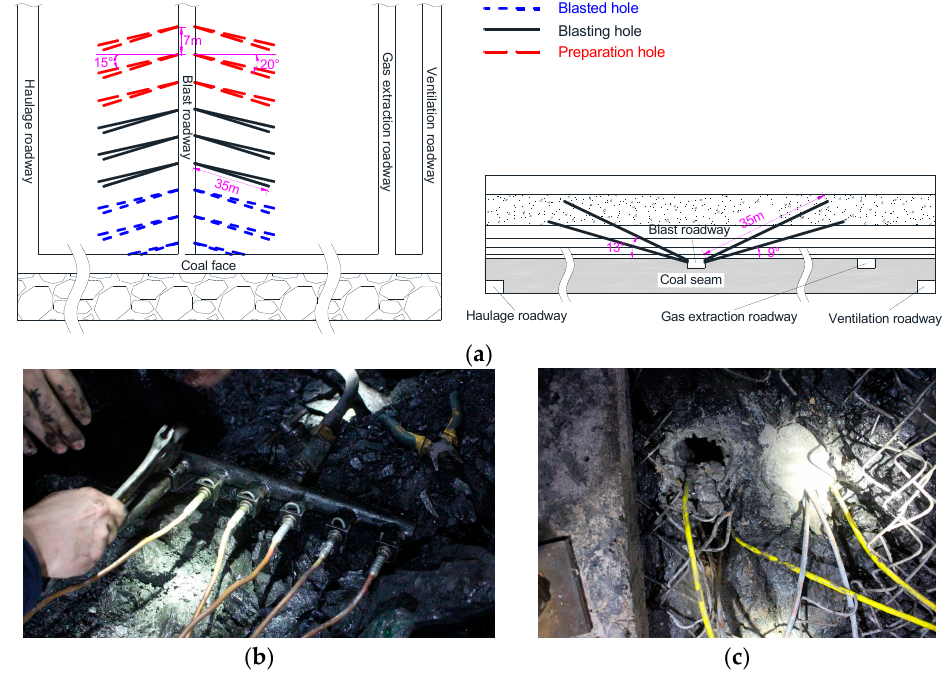
Figure 11. Design of the blasting site and arrangement of pipes: ( a ) Plan and section of the blasting site; ( b ) Arrangement of injection pipes; ( c ) Fixing a pipe at each hole mouth.